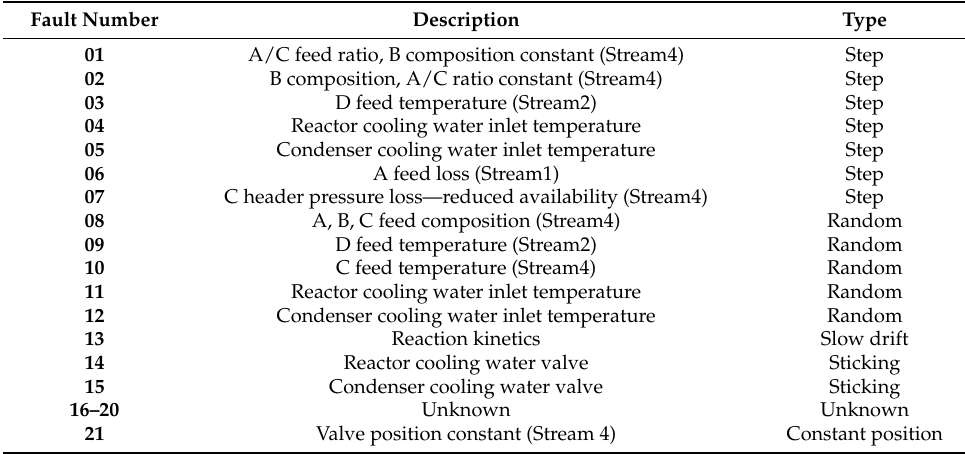
Table 1. Faults for the Tennessee Eastman (TE) process.